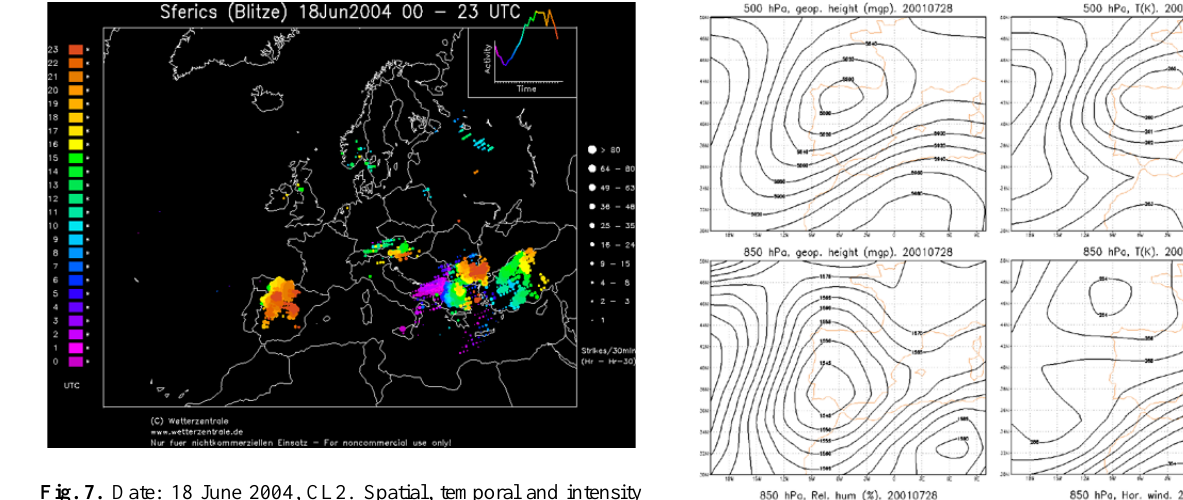
Fig. 7. Date: 18 June 2004, CL2. Spatial, temporal and intensity distribution of lightning events.